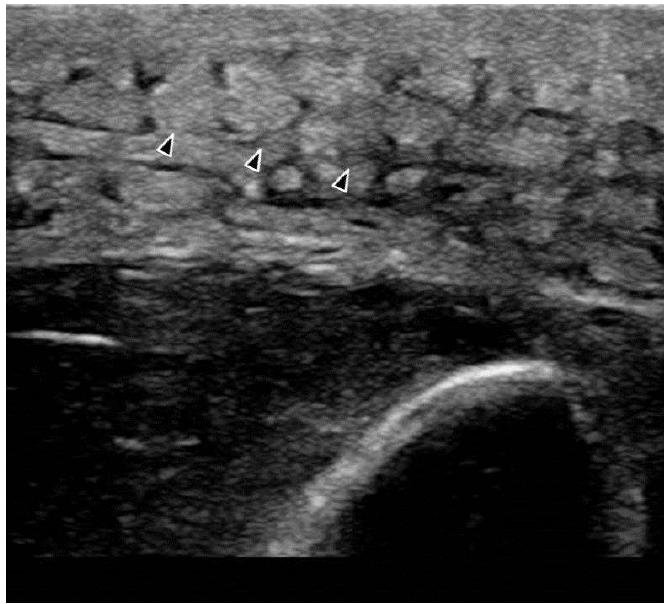
Figure 4. Cobblestone appearance (arrowheads) of subcutaneous tissues suggesting